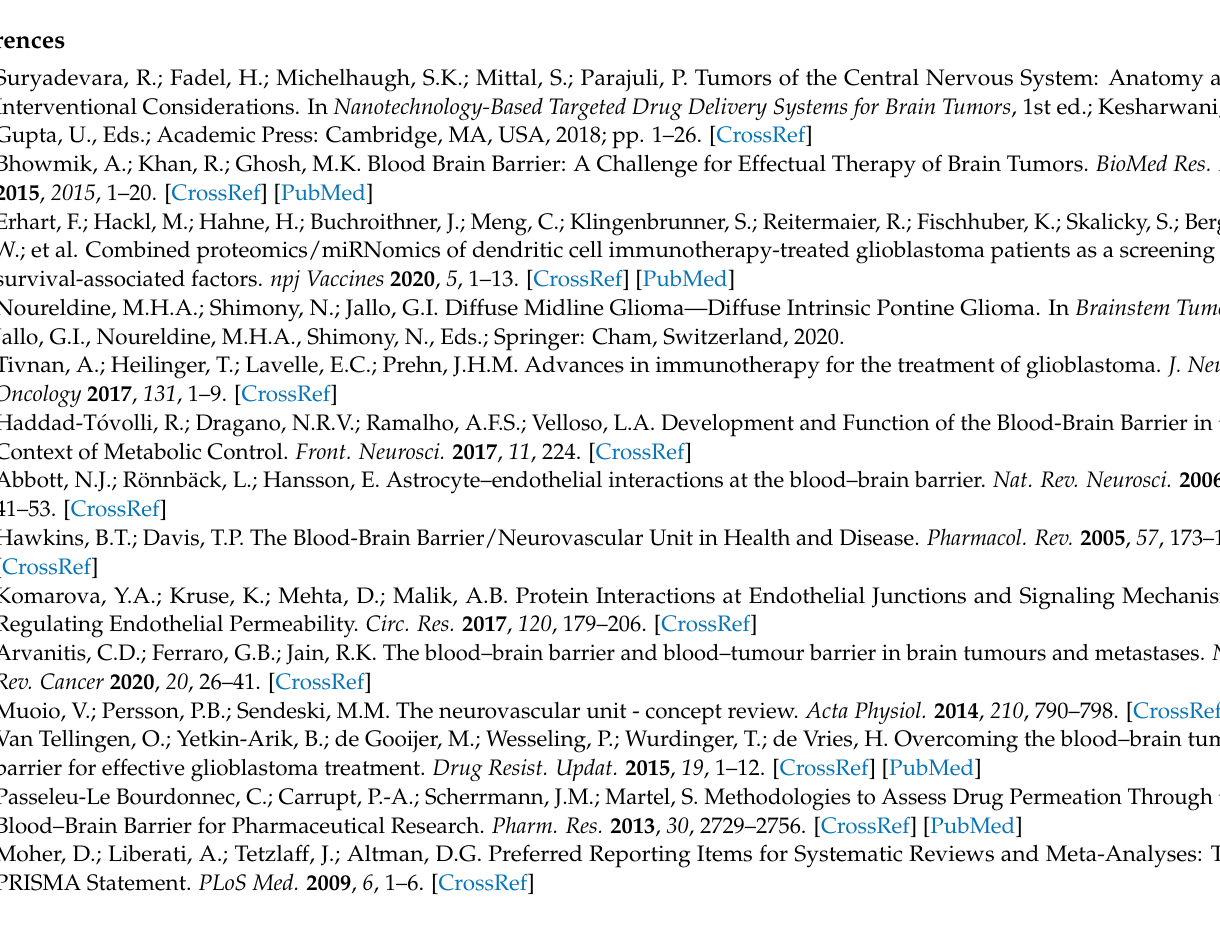
search results, Table S3: Cell lines, advantages and disadvantages of in vitro BBB/BBTB model systems, Table S4: TEER values for transwell in vitro BBB/BBTB models, Table S5: Junctional protein and efflux transporter expression in in vitro BBB/BBTB models, Table S6: Permeability coefficients for in vitro BBB/BBTB